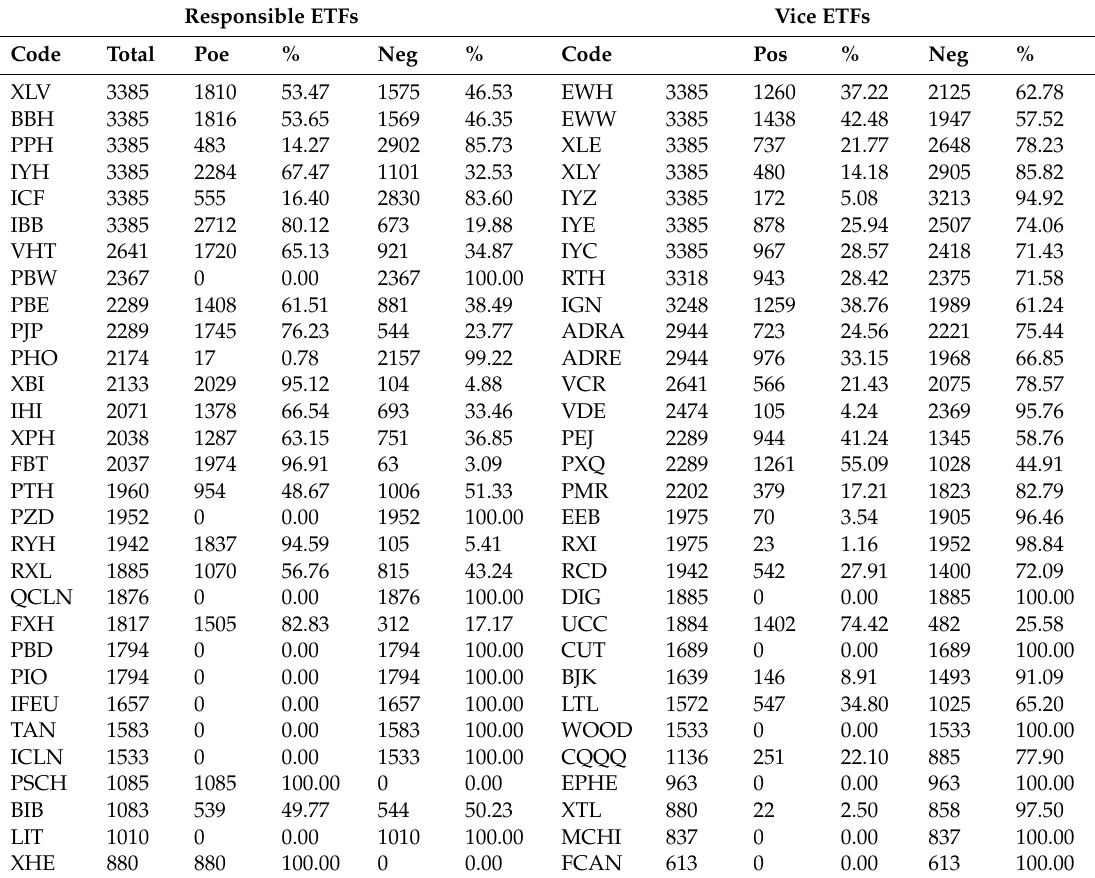
Table 7. Positive and negative alphas over the rolling